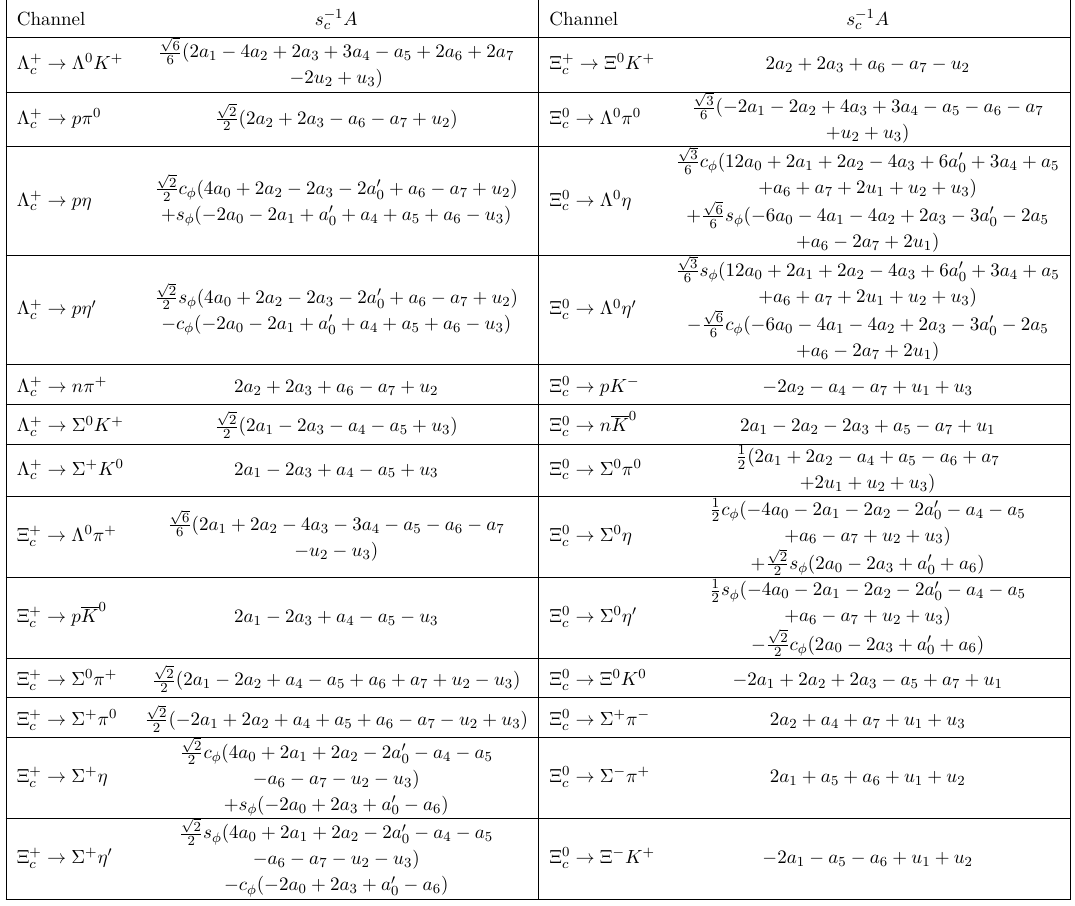
Table 2 . The same as table 1, except for singly Cabibbo-suppressed (SCS) decays of B c → B n M